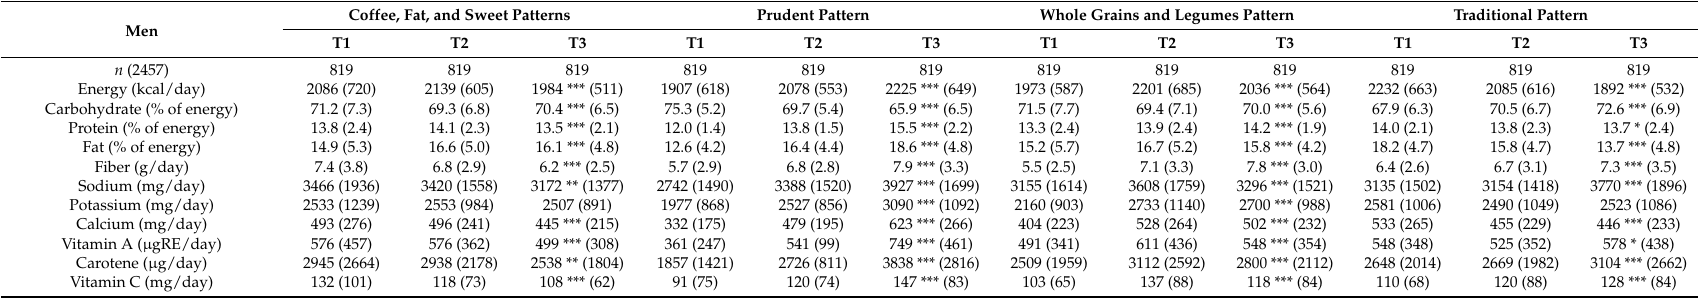
Table 4. Daily nutrient intake of the study participants across the tertiles (T) of dietary pattern scores in men 1,2 . Coffee, Fat, and Sweet Patterns Prudent Pattern Whole Grains and Legumes Pattern Traditional Pattern Men